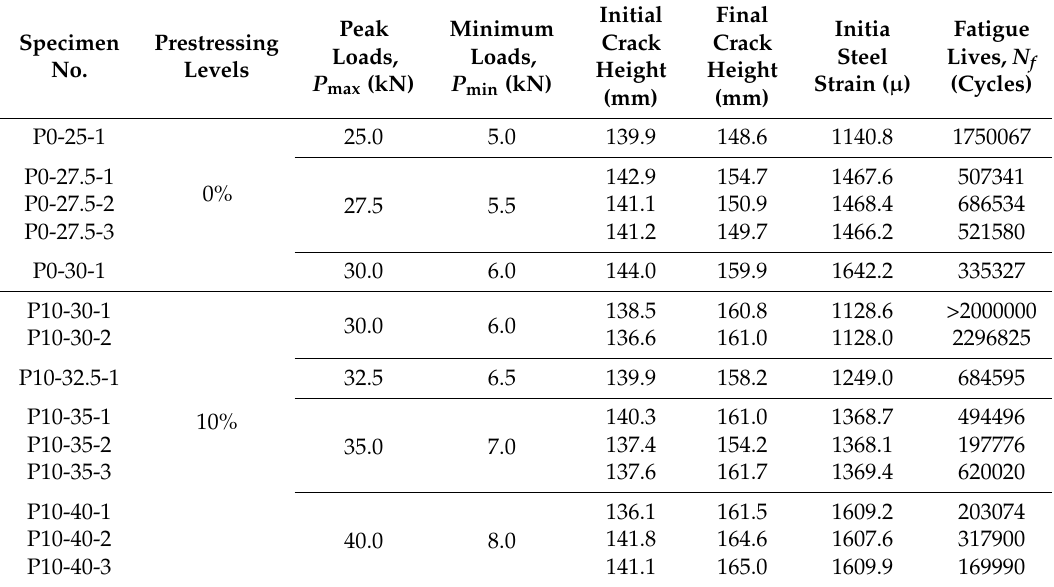
Table 1. Experimental conditions and testing